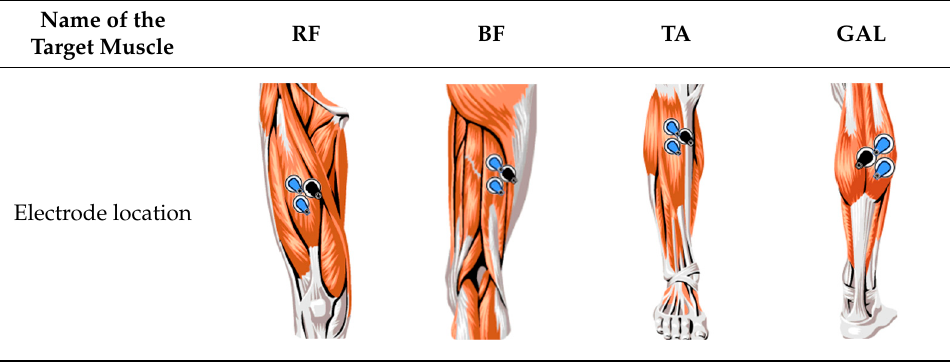
Table 2. Muscle and the electrode location.